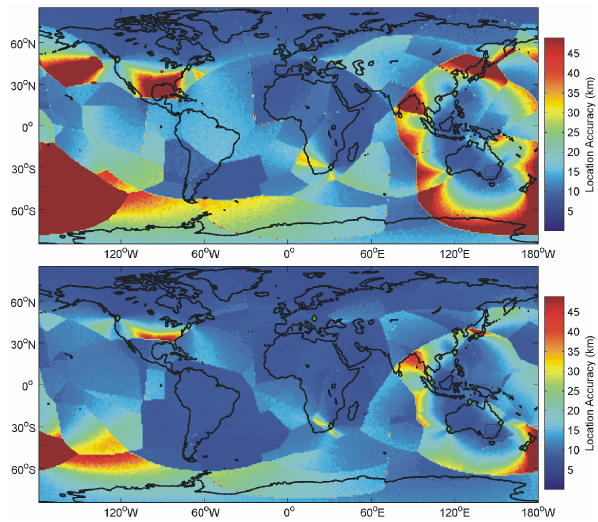
Fig. 11. An estimate of the global location accuracy of the 11 re- ceiving station WWLL network listed in Table 1, assuming a 35 µ s timing error. The upper panel shows location accuracies assuming that only the minimum 4 receiving stations report a lightning event, while the lower panel shows the same situation for 5 receiving sta-